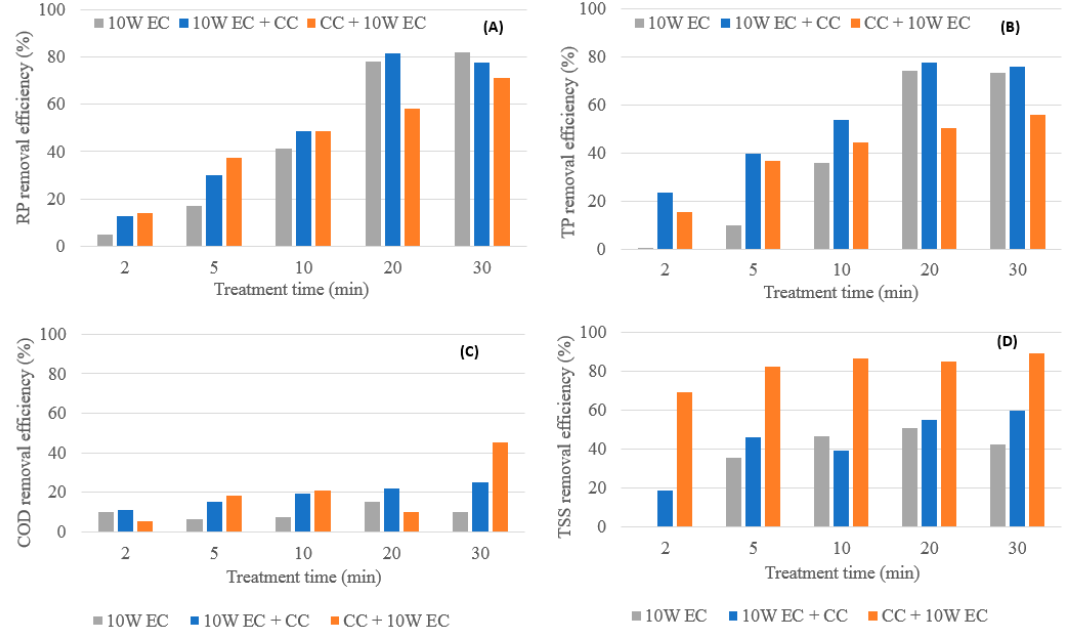
Figure 6. Comparison of removal performance of EC, EC-CC and CC-EC (10 W); ( A ) RP removal performance, ( B ) TP removal performance, ( C ) COD removal performance, ( D ) TSS removal performance (supernatant).